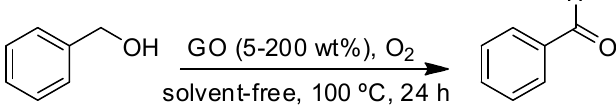
Figure 6. Aerobic oxidation of benzyl alcohol using graphene oxide ‐ based catalysts.